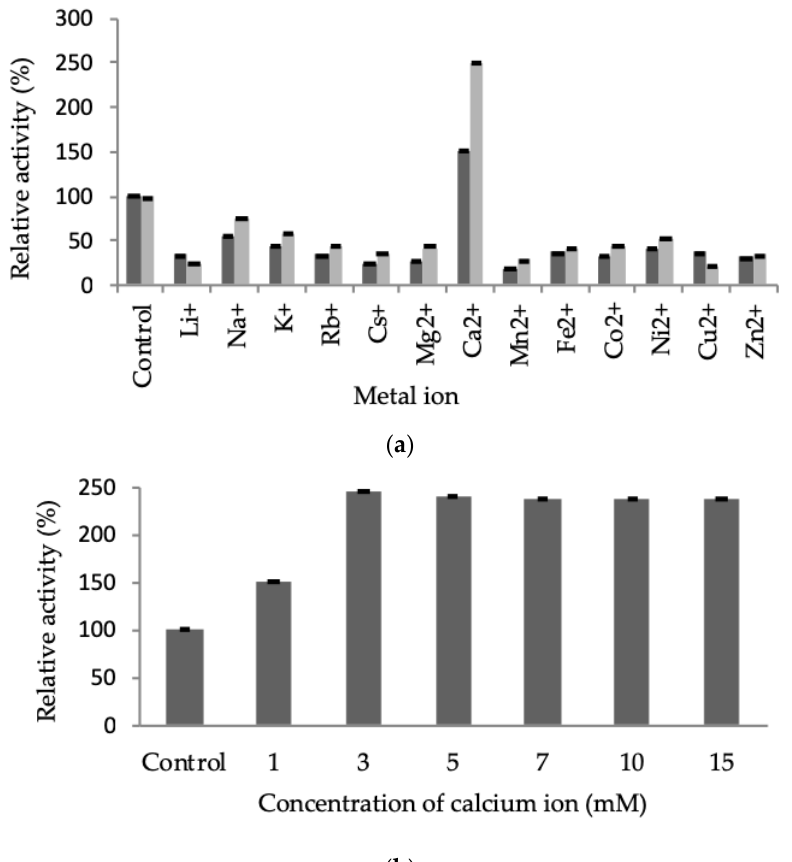
Figure 8. ( a ) Effect of metal ions on LSK25 lipase activity. All assays were carried out using olive oil as substrate. The enzyme was pre-incubated at 25 °C with various metal ions at concentrations of 1 mM (black) and 5 mM (grey). ( b ) Effect of concentration of calcium ions (1–15 mM). The enzyme was pre-incubated at 25 °C for 30 min prior to lipase assay. The assays took place at 30 °C for 30 min. The control consisted of the absence of metal ions), with activity expressed relative to the control value. Error bars represent standard deviation ( n =